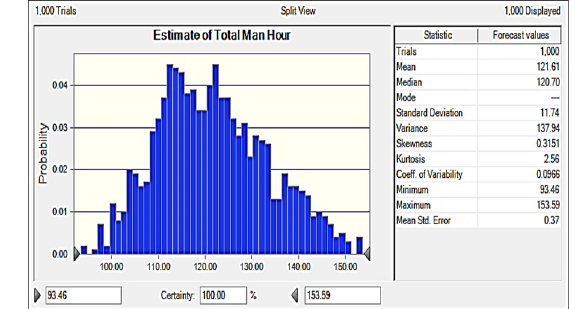
Fig. 6: Estimate of Total Man Hours at 100% Certainty